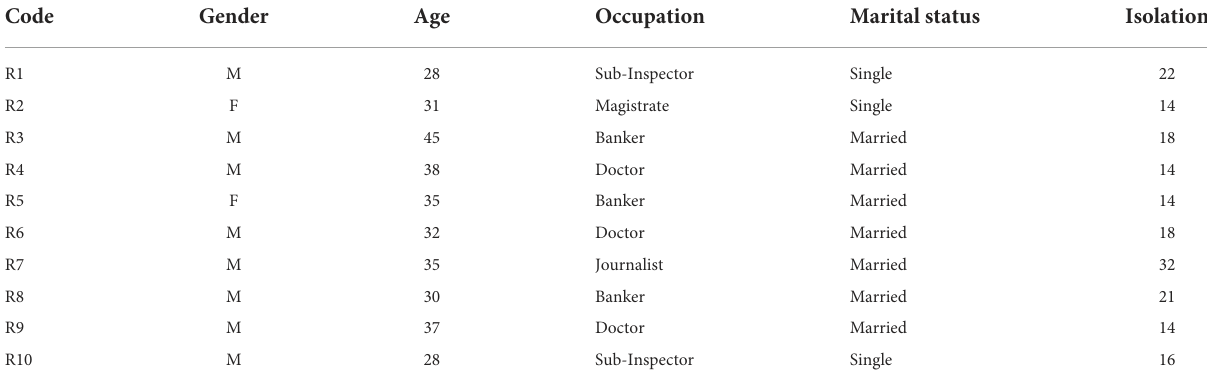
TABLE 1 Characteristics of